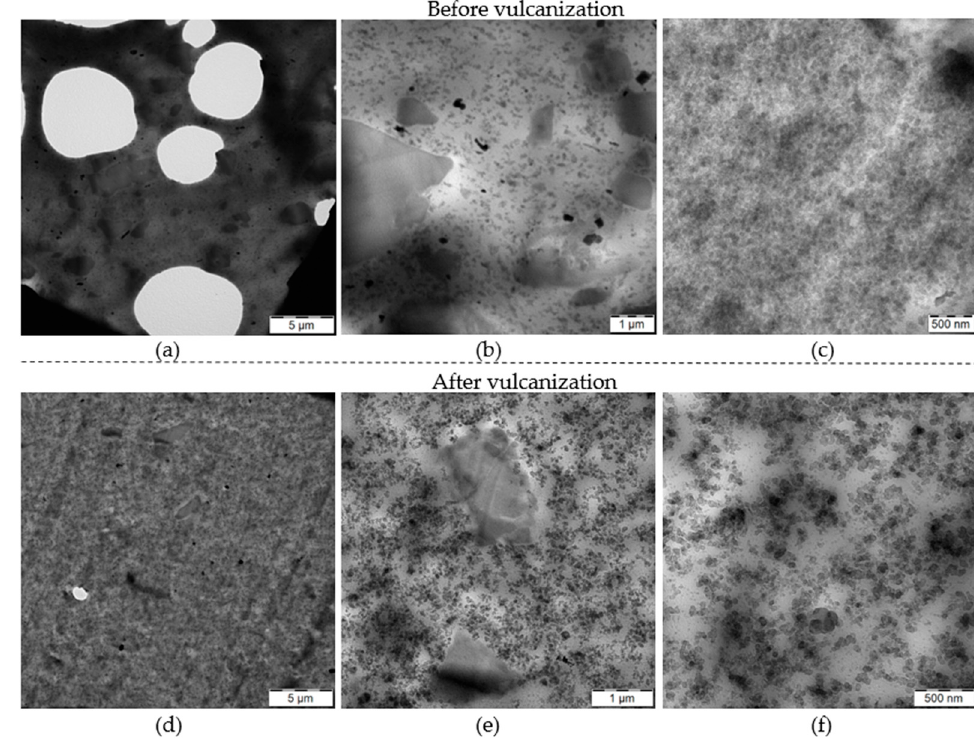
Figure 4. TEM images of the sample filled with 40 phr (25.16 wt.%) of hydrochar and 10 phr (6.29 wt.%) of carbon black: ( a – c ) unvulcanized state: sample CB40; ( d – f ) vulcanized state: sample VCB40; ( a , d ): ‘global view’—5 µm scale bar; ( b , e ): 1 µm scale bar; and ( c , f ): 500 nm scale bar.